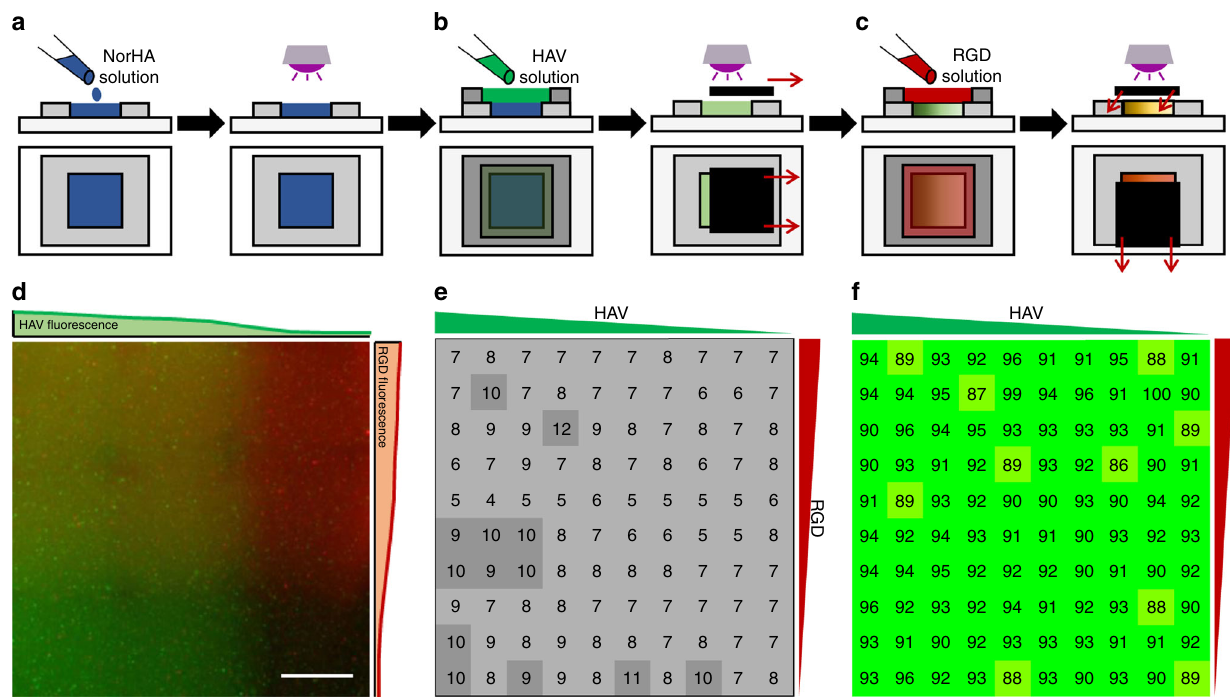
Fig. 4 Scheme for fabricating orthogonal biochemical gradients and characterization. a Norbornene-modi fi ed hyaluronic acid (NorHA) hydrogels were prepared on 5 × 5 × 0.5 mm 3 molds via a thiol-norbornene UV light-mediated reaction between NorHA and di-thiol (DTT) crosslinker. b Hydrogels were then incubated in 5 mM mono-thiolated HAV peptide solution for 30 min and a gradient was generated with an opaque horizontal sliding mask to control the extent of light-mediated reaction between HAV peptides and norbornenes in the hydrogel. After washing, the hydrogel was then ( c ) incubated in 5 mM mono-thiolated RGD peptide solution for 30 min and an opaque sliding mask in the vertical direction was used to introduce a secondary orthogonal gradient. d Images of rhodamine-labeled RGD and fl uorescein-labeled HAV orthogonal gradients, including quanti fi ed intensity pro fi les on each side.